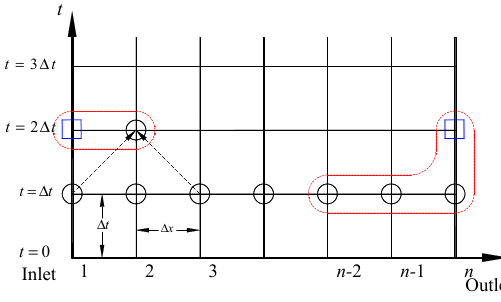
Figure 3. Boundary model of the pipe ends.